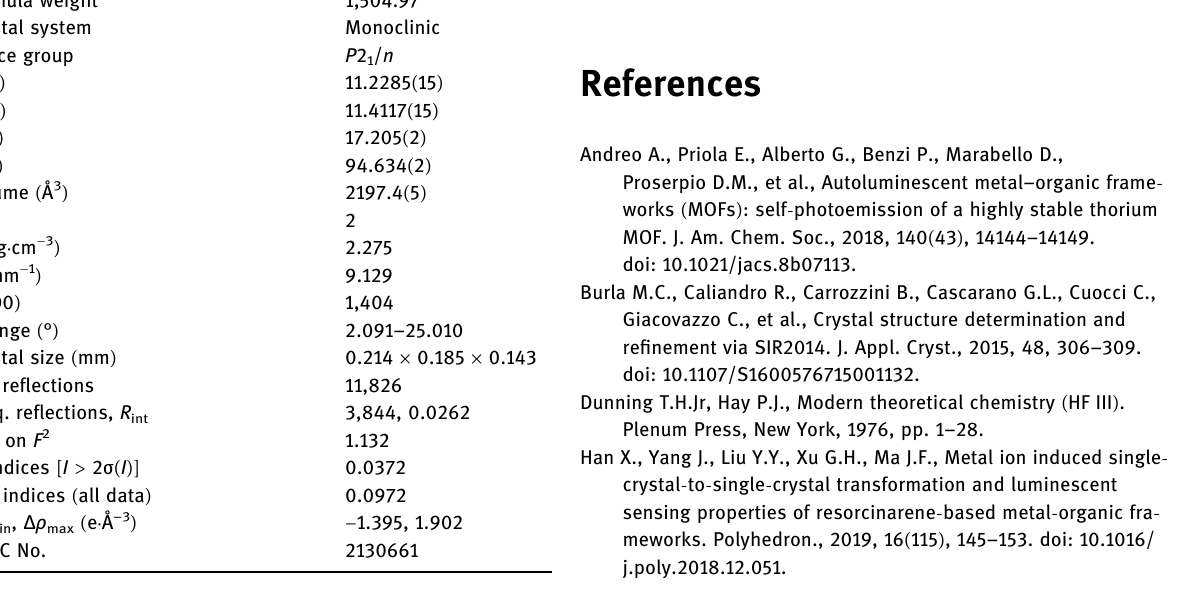
Table 3: Crystalline data and re fi nement parameters for complex 1 Empirical